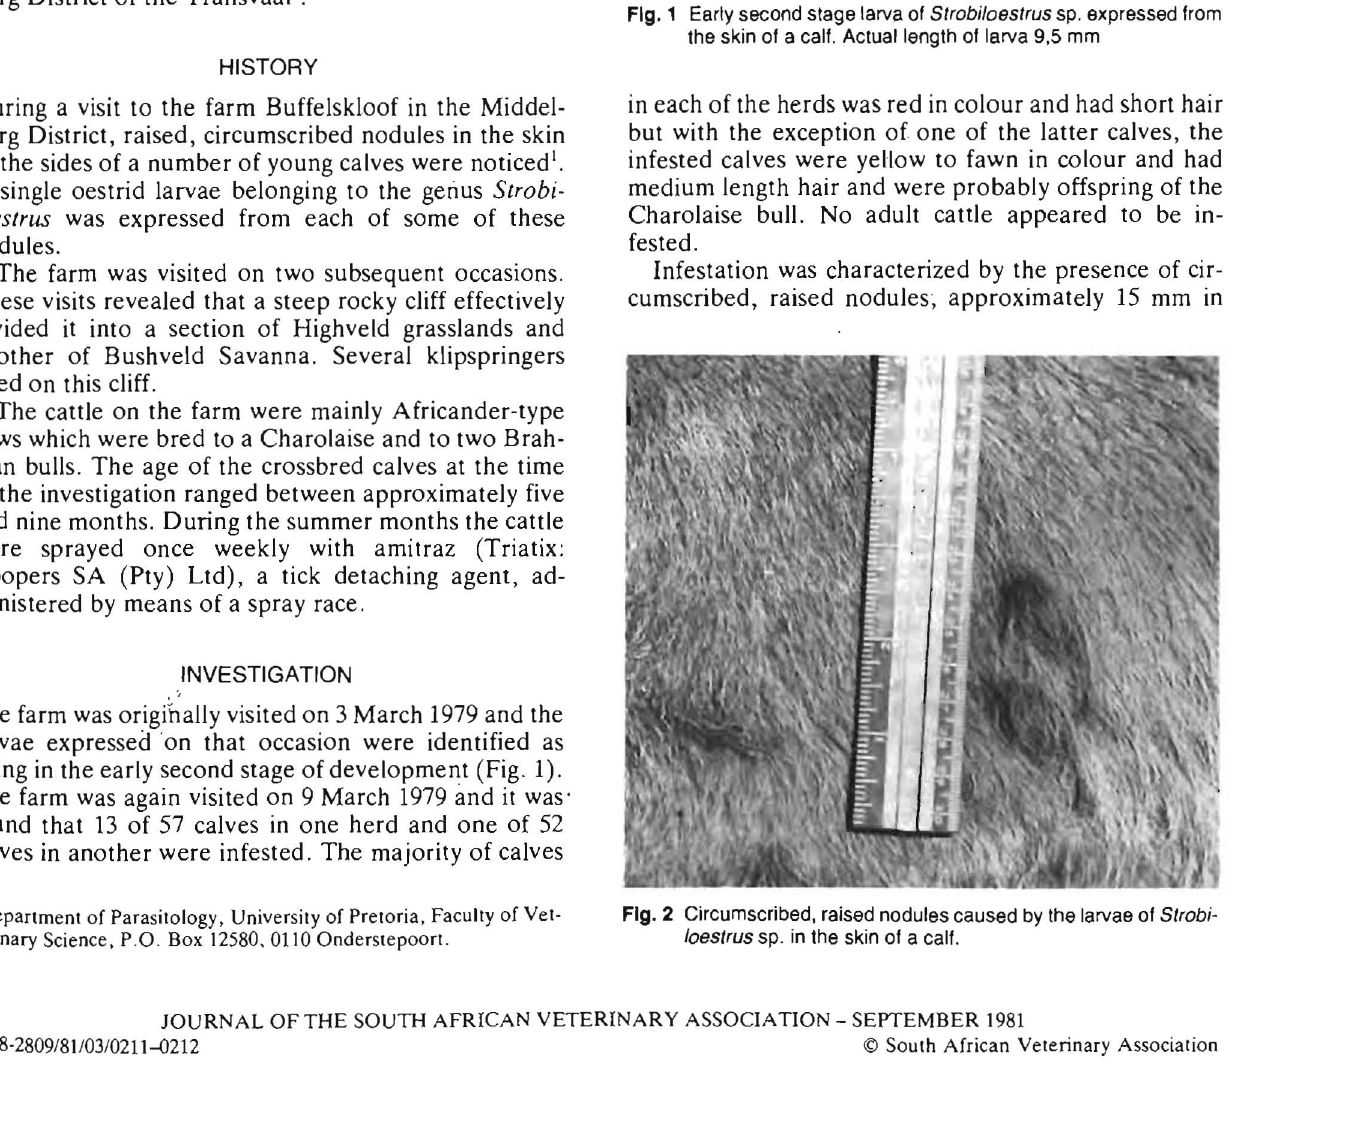
FIg. 1 Early second stage larva of Strobiloestrus sp. expressed from the skin of a calf. Actual length of larva 9.5 mm in each of the herds was red in colour and had short hair but with the exception of one of the latter calves, the